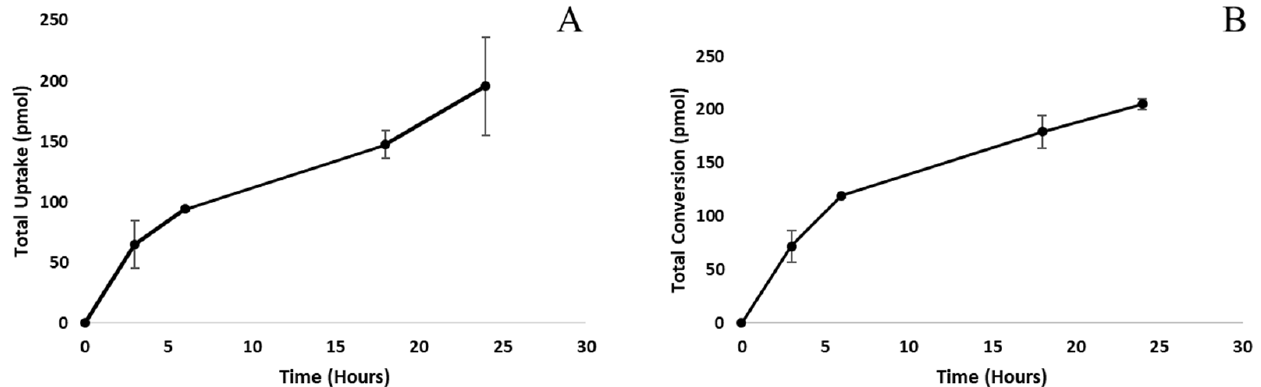
Figure 2. Isolated adipocytes were incubated with radiolabeled androstenone sulfate for 3, 6, 18, and 24 h. Steroids were extracted from the fat and detected by HPLC to quantify total uptake ( A ) or the production of free androstenone from androstenone sulfate ( B ). Data are presented as the mean ± standard error from 3 separate experiments.